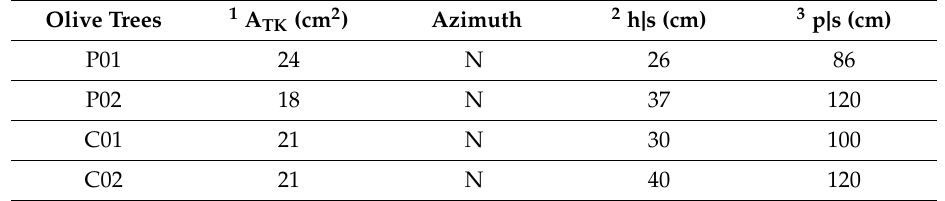
Table 2. Description of the diameter trunk and sensor localisation on the tree. Olive